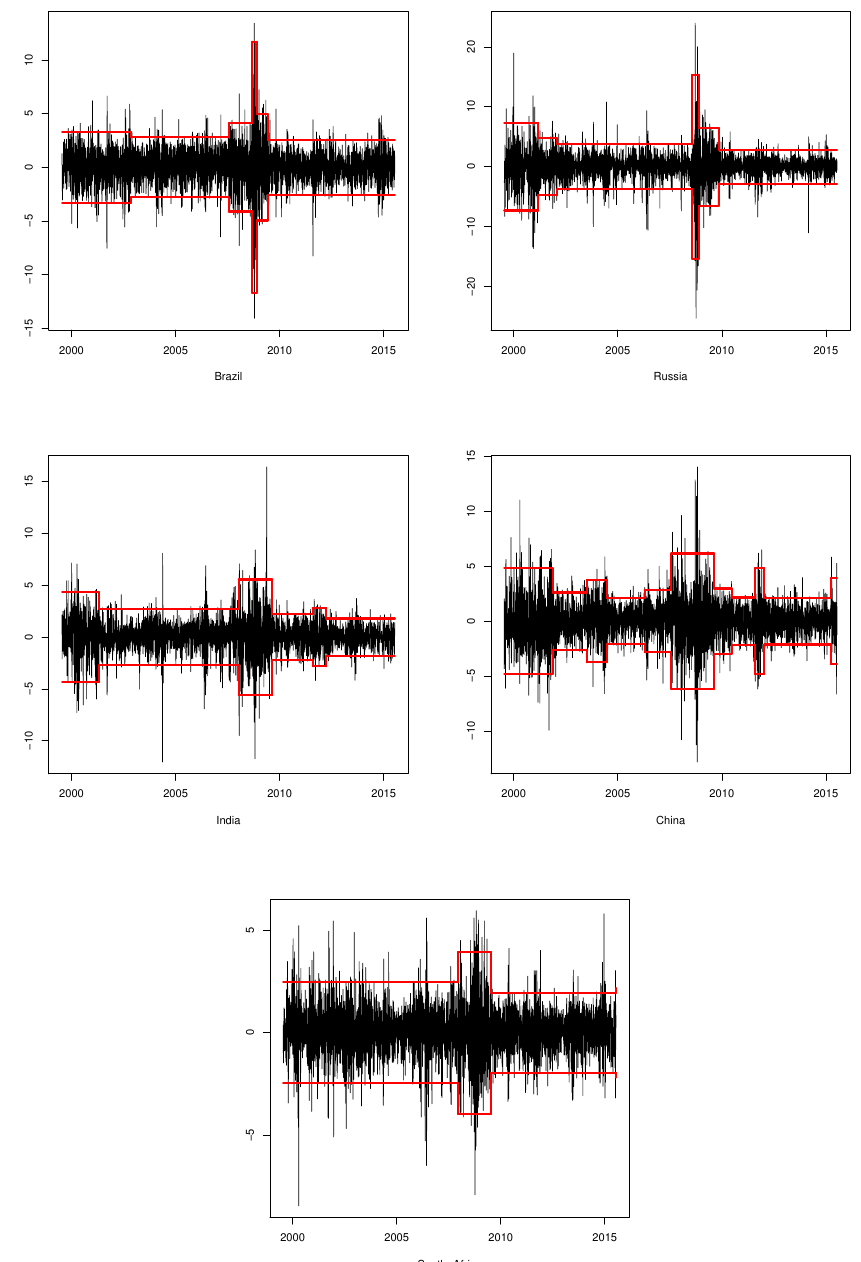
Figure 1. MSCI daily returns on BRICS countries from 19 July 1999 to 16 July 2015 and two-standard- deviation bands for the regimes defined by the structural breaks identified by the binary segmentation with K 2